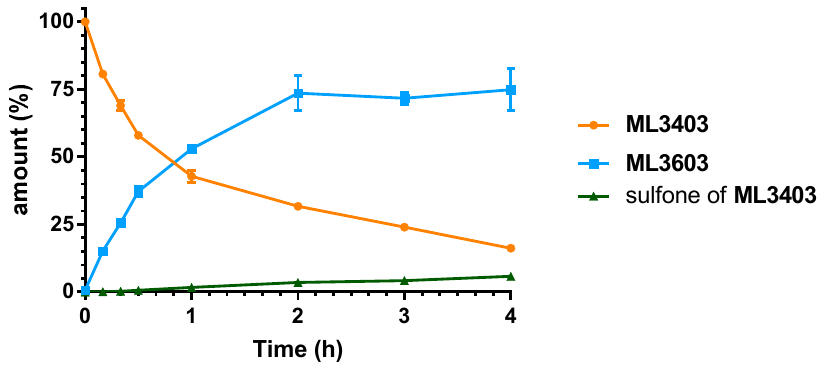
Figure 3. Metabolic stability of ML3403 and the formation of main metabolites (sulfoxide ML3603 and sulfone).